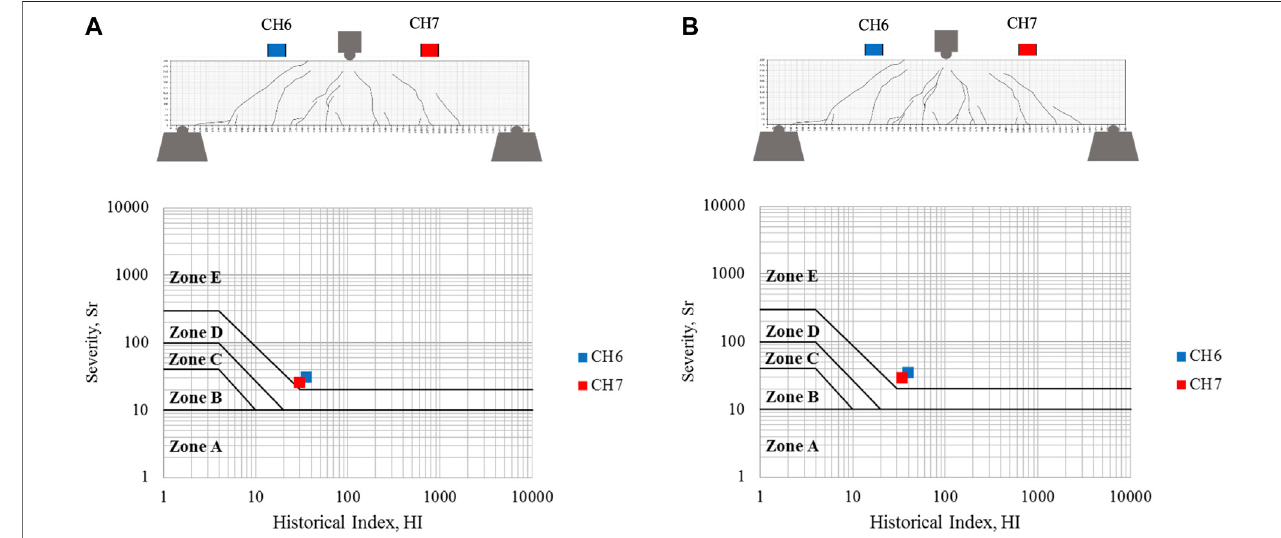
FIGURE 14 | The crack zones obtained from CH6 and CH7 for beam S2B, (A) CM5 and (B) CM6.